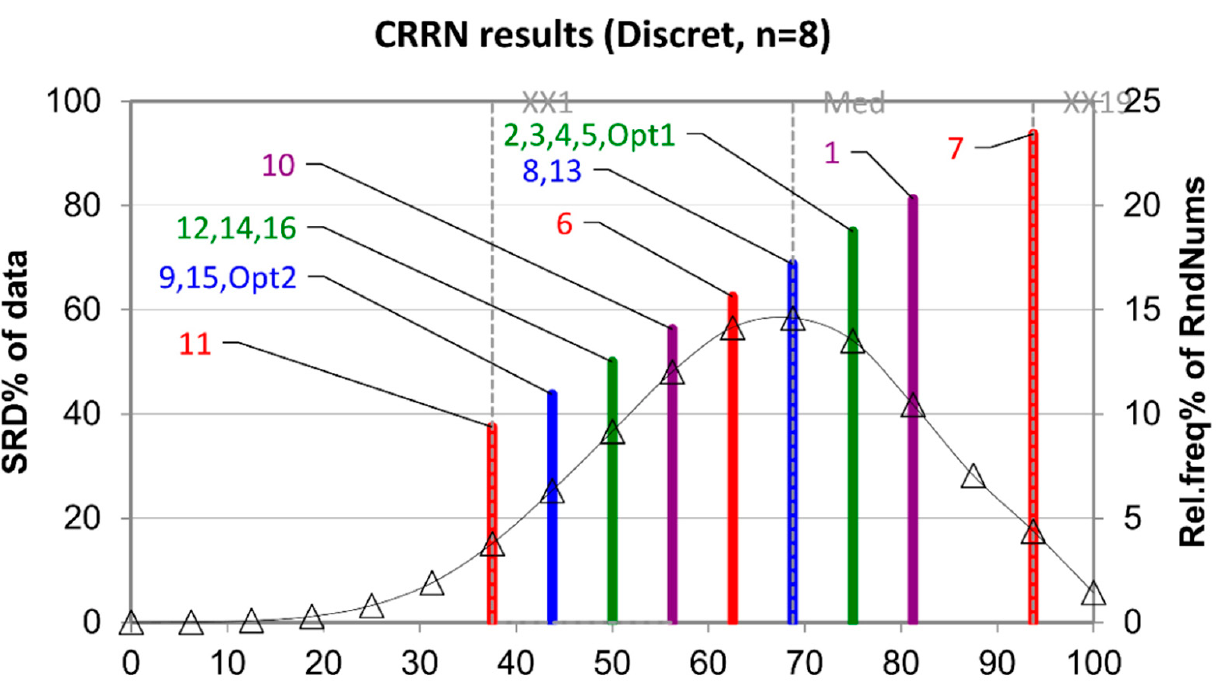
Figure 4. The graphical representation of the results of SRD analysis of the extraction experiments 1–16 and optimal solvent ( Opt1 ) and optimal ternary solvent mixture composition ( Opt2 ). The statistical characteristics of the theoretical distribution functions are first icosaile (5%), XX1 = 12; first quartile, Q1 = 18; median, Med = 22; last quartile, Q3 = 24; last icosaile (95%), XX19 =